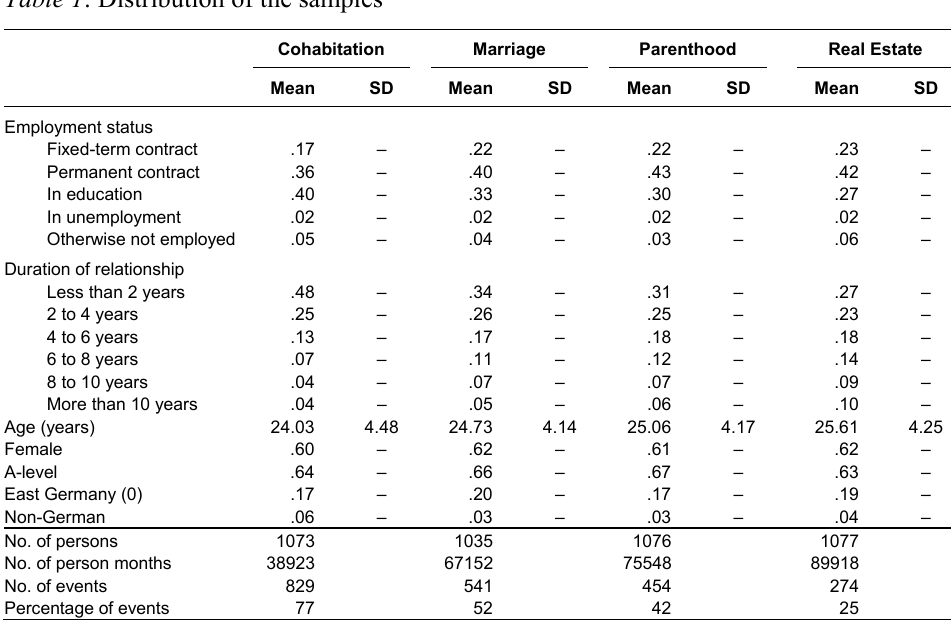
Table 1 : Distribution of the